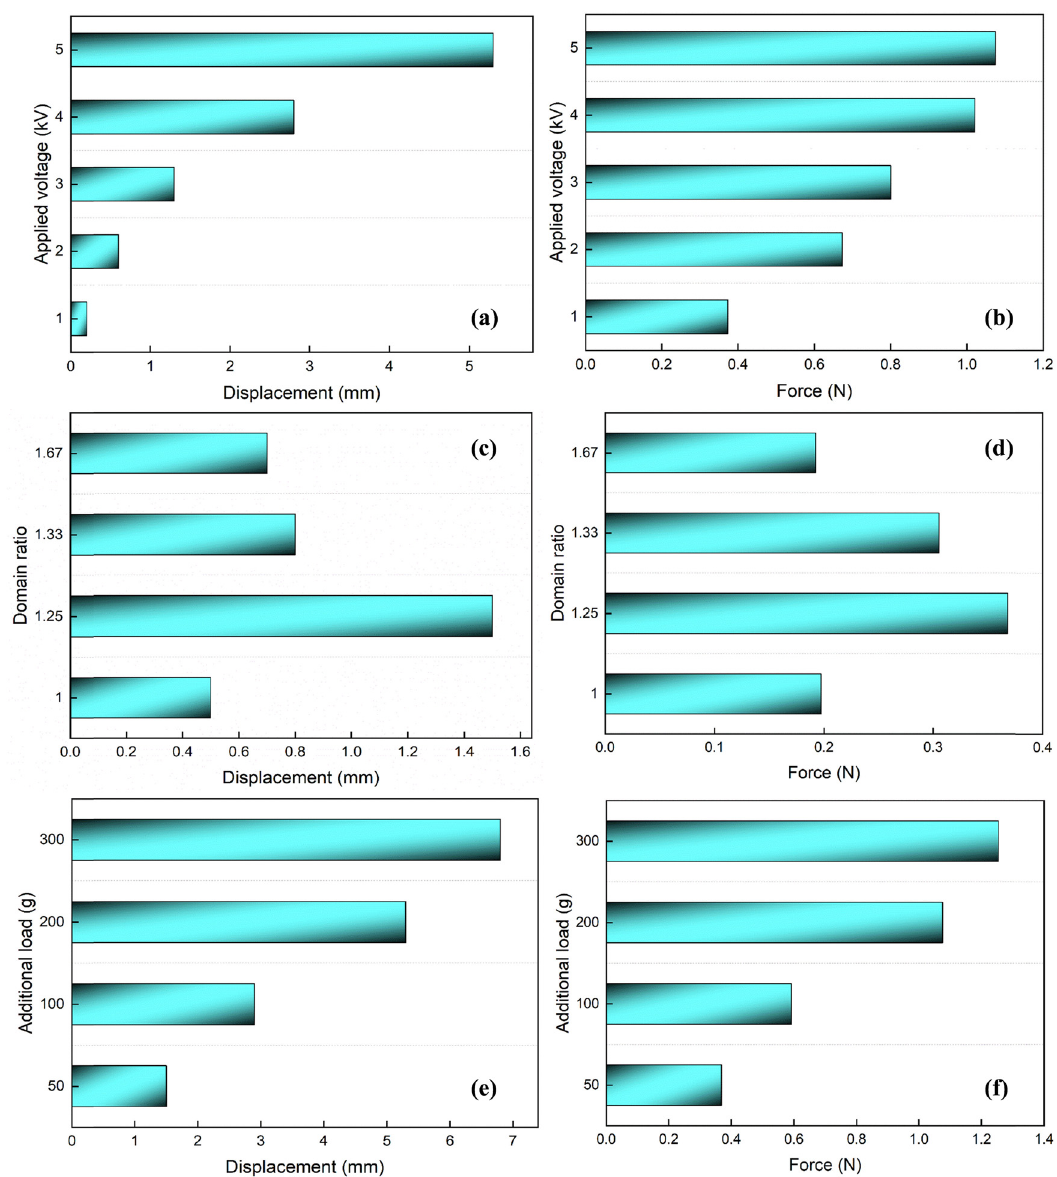
Figure 2: Actuation performance of conical actuators: ( a ) loading voltage vs displacement; ( b ) loading voltage vs force; ( c ) domain ratio vs displacement; ( d ) domain ratio vs force; ( e ) additional load vs displacement; and ( f ) additional load vs